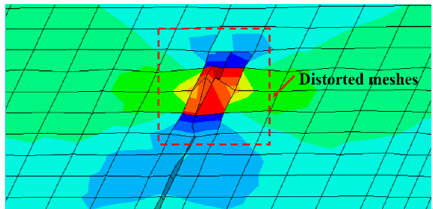
Figure 7. Distorted meshes using C3D8RP in hydraulic fracturing problems .